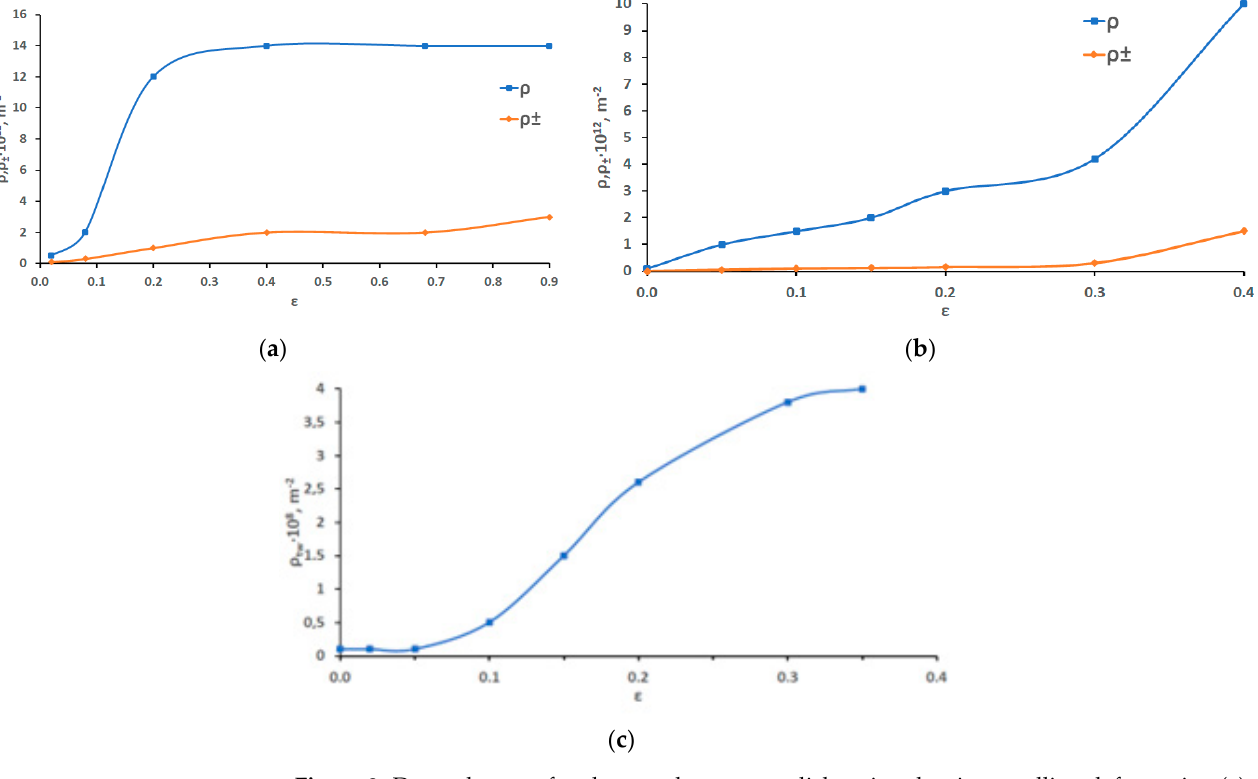
Figure 8. Dependences of scalar ρ and excess ρ ± dislocation density at rolling deformation ( a ), at tensile deformation ( b ) and ρ tw ( c ) on the plastic deformation degree in Hadfield steel.